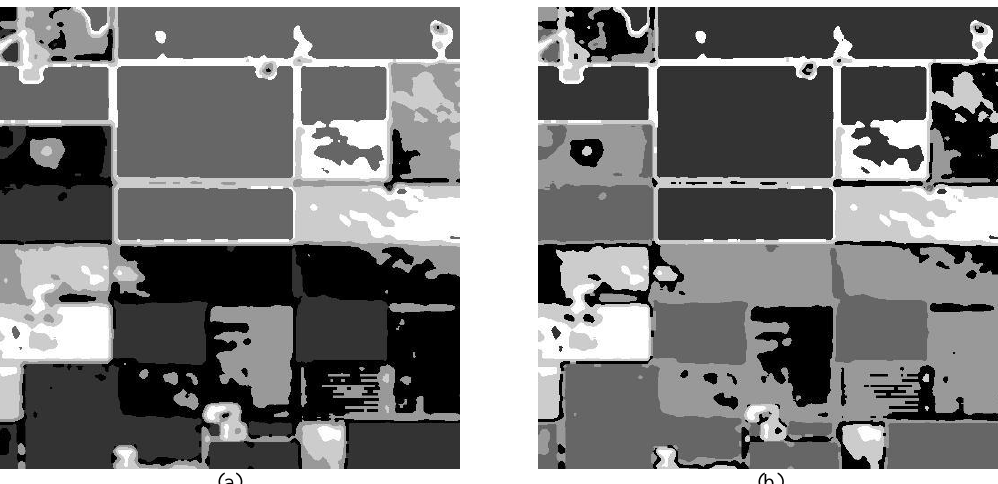
Figure 6. Result of segmentation. (a) FCM clustering with 9 × 9 windowsize (b) k-means clustering 9 × 9 windowsize